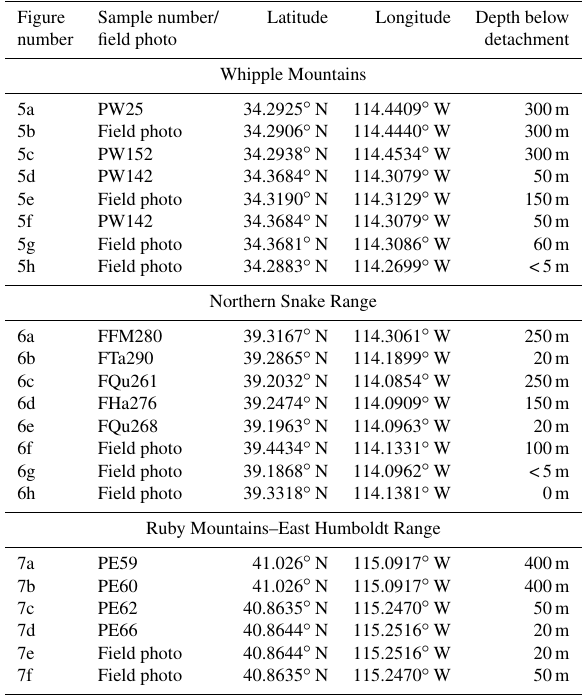
Table 1. Sample and field photo locations. Figure Sample number/ Latitude Longitude Depth below number field photo